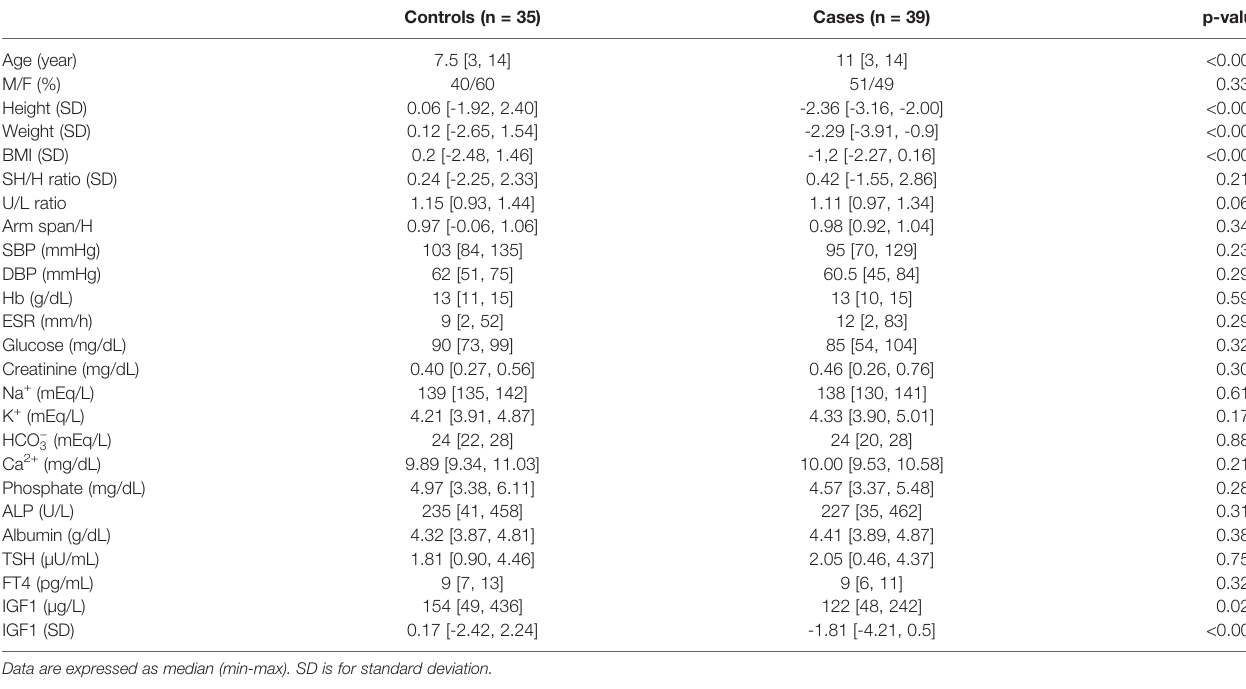
TABLE 1 | General characteristics of whole cohort.